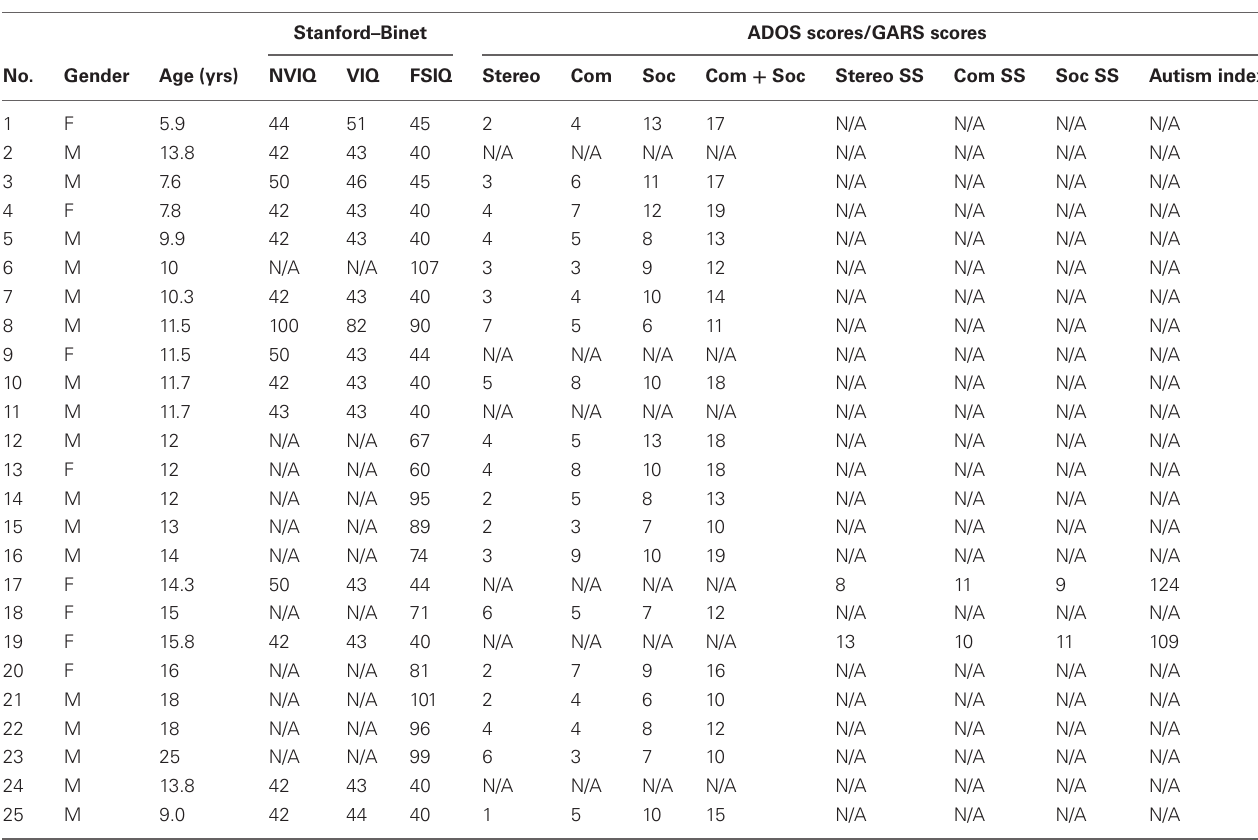
Table A1 | Scores of the participants with ASD reported from independent clinical assessments by licensed